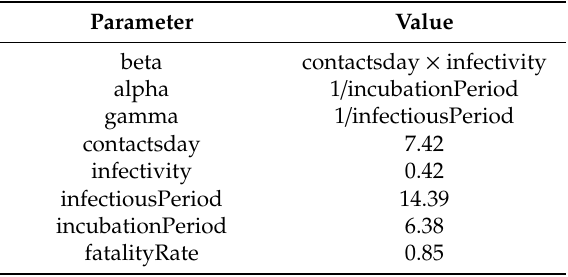
Table 1. Parameters for the validation between the di ff erent